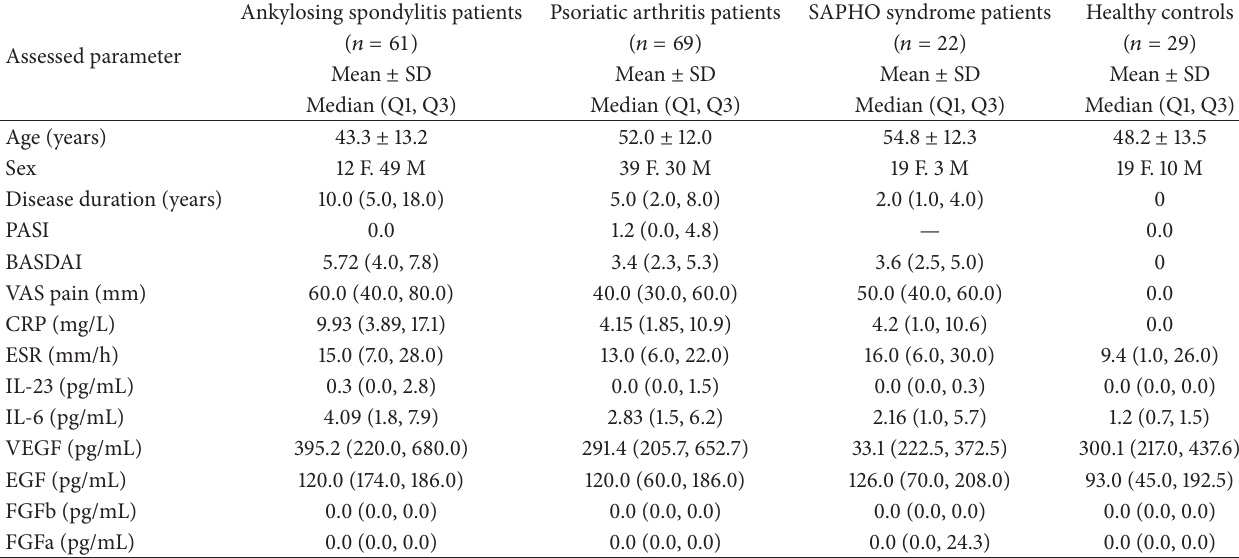
FGFa: acidic fibroblast growth factor. FGFb: basic fibroblast growth factor.